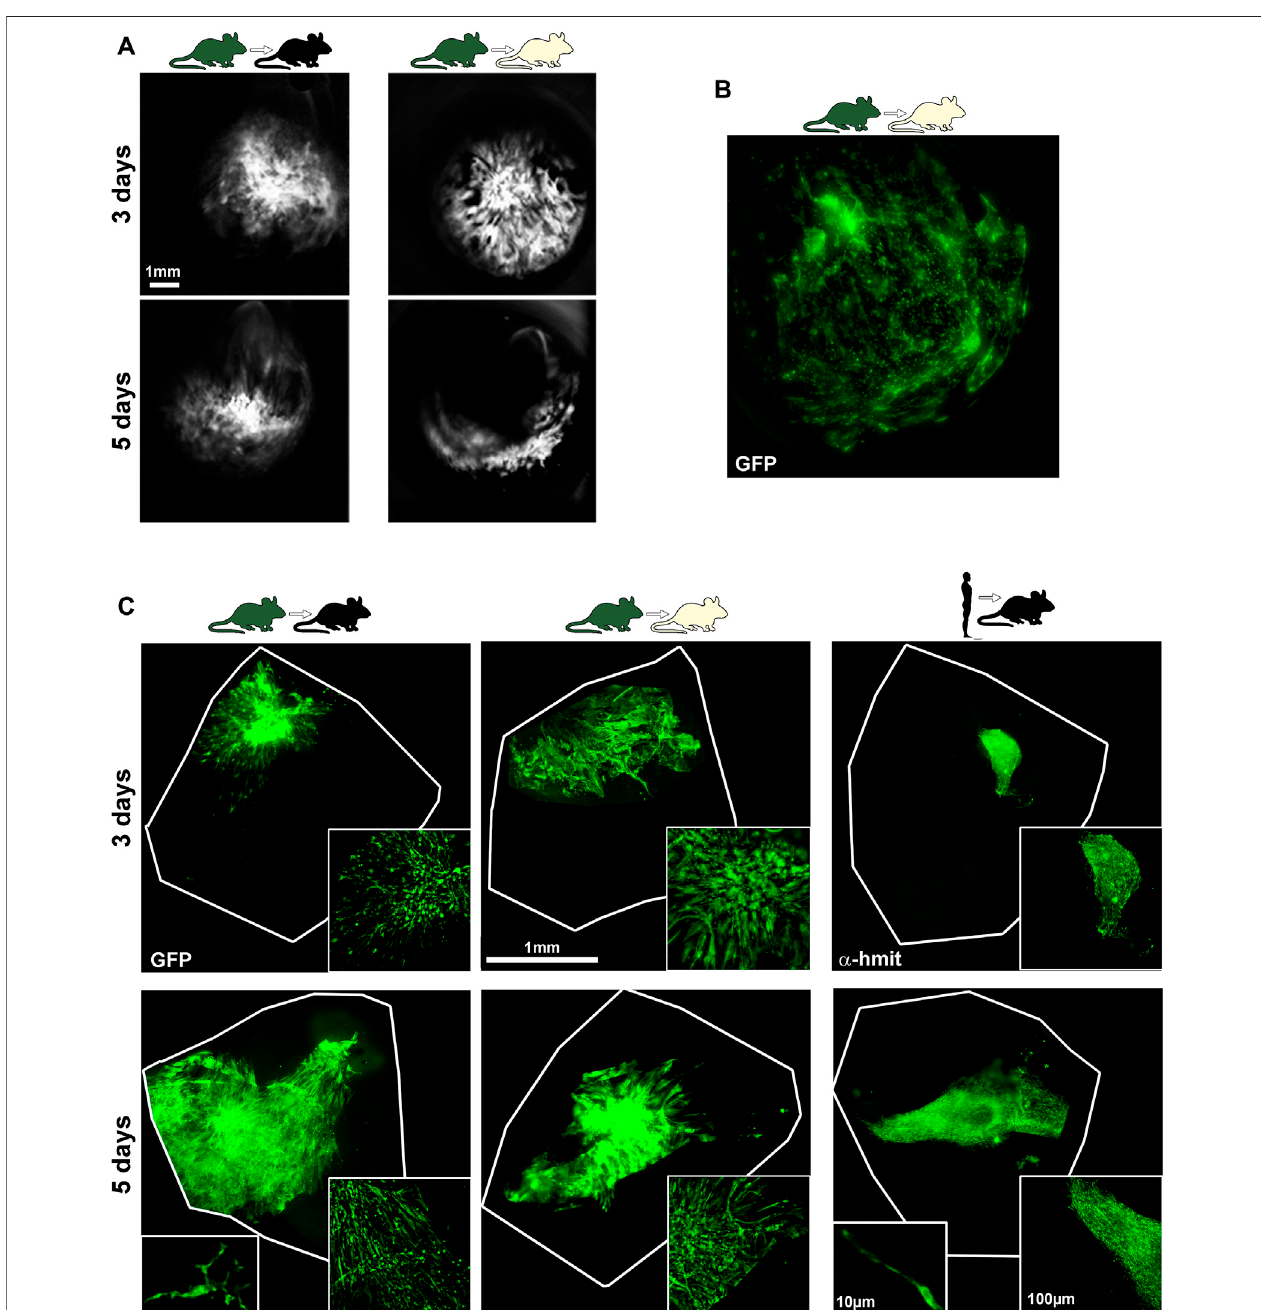
FIGURE3| VisualizationofBM-MSCs. (A) : Invivo OCTimagesshowingmBM-MSCsinthevitreousbodyat3and5 daysaftersyngeneic(left)andallogeneic(right) transplants. (B,C) : Ex vivo , mBM-MSCs were observed attached to the lens [ (B) , allogeneic transplant] and on the retinal surface forming a mesh (C) . In (C) , the retinal petals where cells were injected are outlined. At the bottom right of each image is shown a magni fi cation of the BM-MSC meshes. At the bottom left of 5 days syngraft and xenograft panels are shown high power magni fi cations of individual mouse and human BM-MSCs, respectively. Grafts were observed at 3 and 5, but not at 90 days. α -h-mit: anti-human mitochondrial